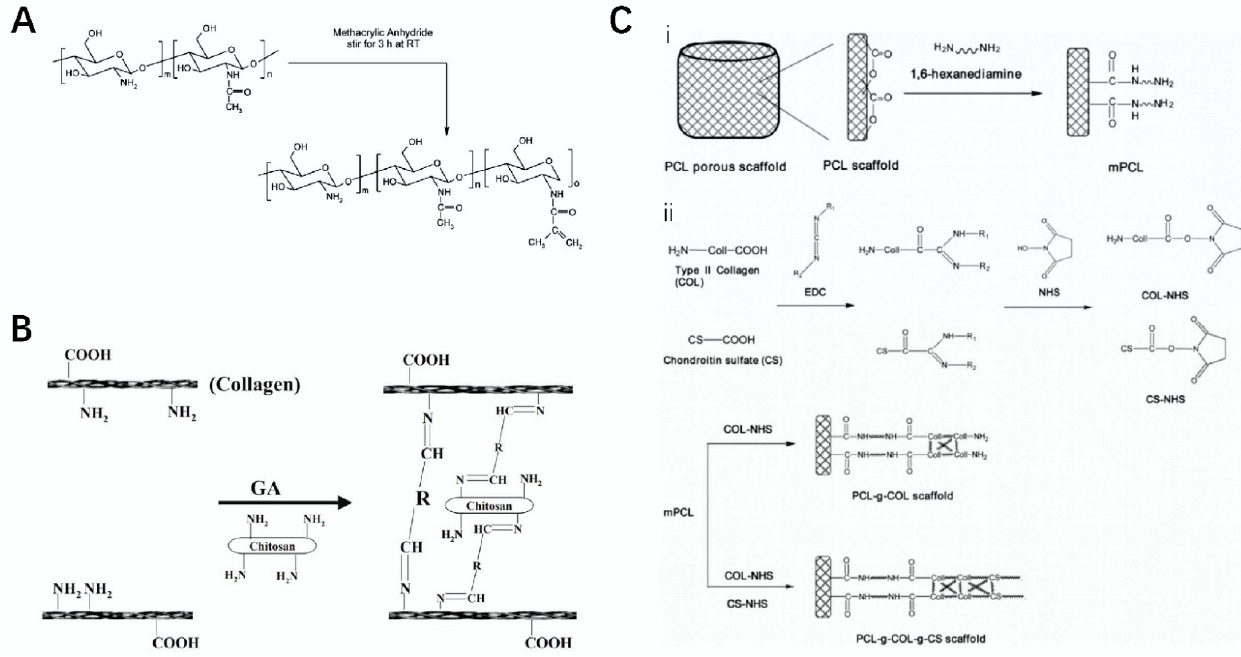
Figure 2. Synthesis roadmap of polysaccharide materials. ( A ) schematic diagram of the preparation of methyl acrylamide chitosan (MC) [30]. ( B ) schematic diagram of the preparation of a glutaraldehyde-modified collagen–chitosan composite scaffold [31]. ( C ) schematic diagram of the preparation of Poly ( ε -caprolactone) (PCL)-modified chondroitin sulfate composite scaffold [33].